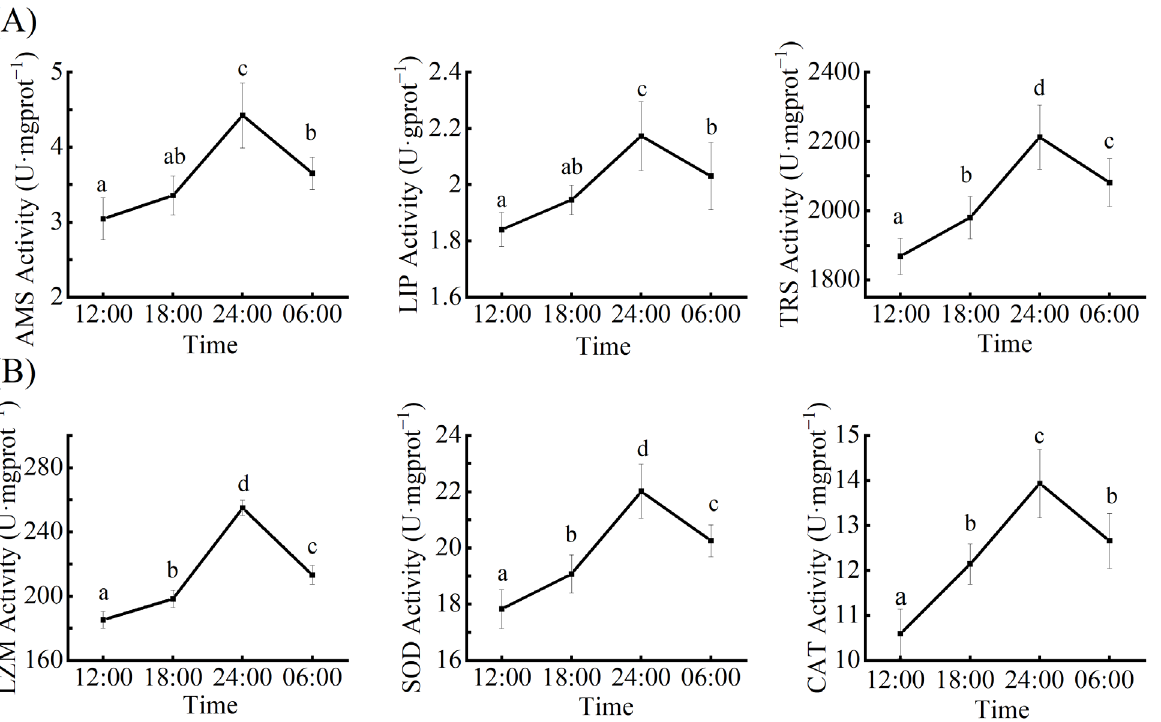
Figure 1. The Circadian Rhythm of enzyme activities. ( A ) α -amylase (AMS) activity diagram, Lipase (LIP) activity diagram, and Trypsin (TRS) activity diagram. ( B ) Lysozyme (LZM) activity diagram, Superoxide dismutase (SOD) activity diagram, and Catalase (CAT) activity diagram.